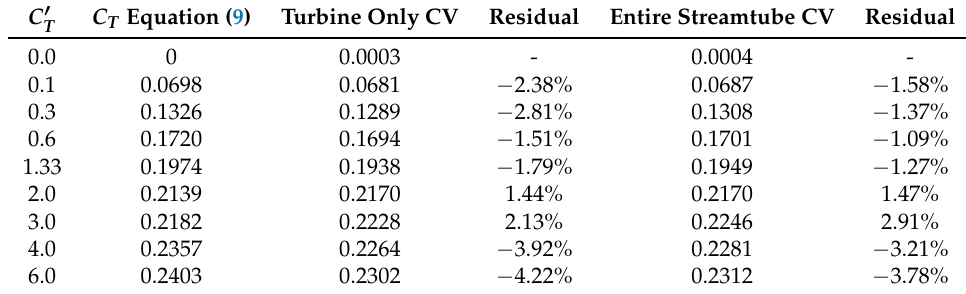
Table A2. Comparison of C P calculations using different methods. “Turbine Only CV” and “Entire Streamtube CV” are computed by summing the terms on the right hand side of Equation (7). Residuals are shown as a percentage of C P calculated directly from Equation (5), except for C (cid:48) by